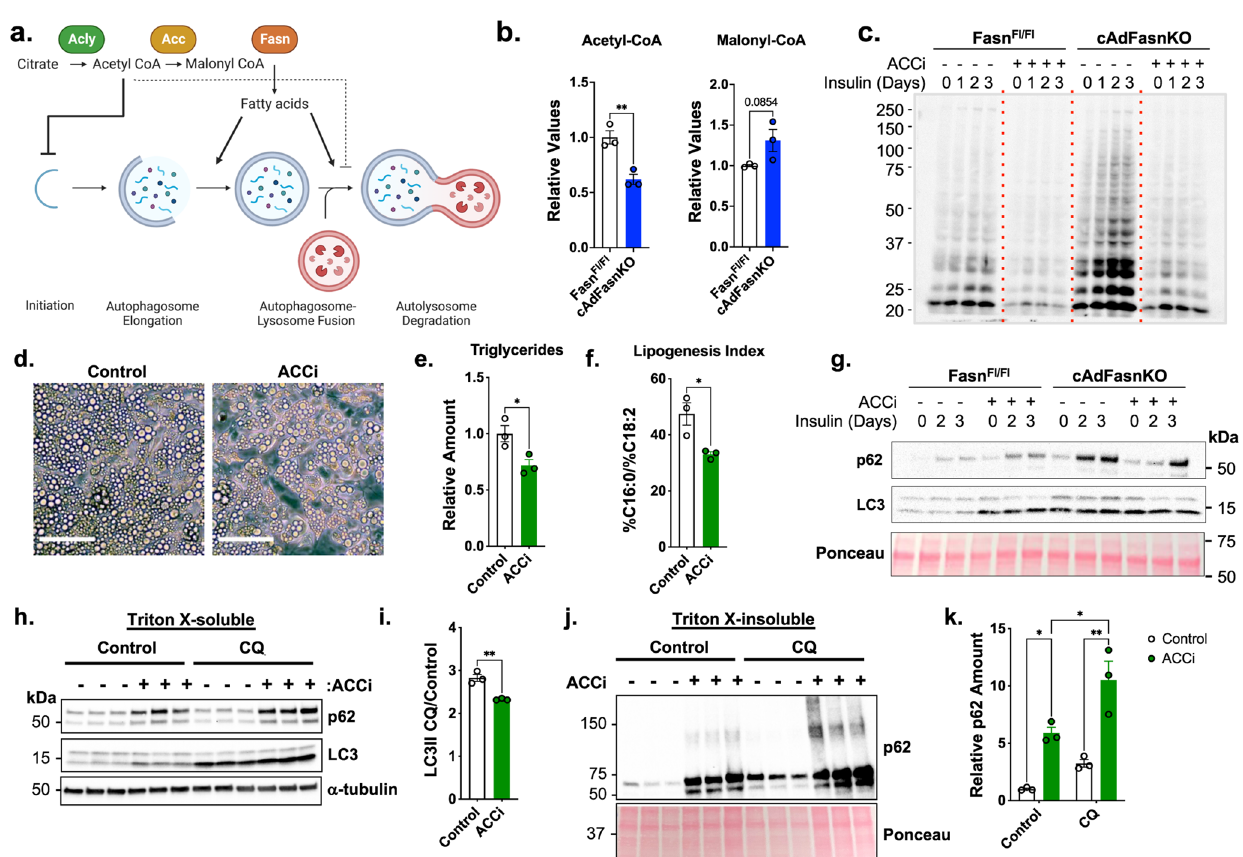
Fig. 2 | DNL metabolites acetyl-CoA and malonyl-CoA do not mediate the impaired autophagy in cultured FasnKO adipocytes. a Diagram of de novo lipogenesis and its proposed role(s) in autophagy. Figure created with BioRender. b Relative acetyl-CoA and malonyl-CoA levels in Fasn Fl/Fl and cAdFasnKO adipo- cytes determined by LC-MS/MS. n =3 samples. Two-tailed t test: P value (Acetyl- CoA) = 0.0075, **<0.01. c Western blot of malonylated proteins in Fasn Fl/Fl and cAdFasnKO adipocytes in the presence of 15 μ M ND-630 (ACC inhibitor, ACCi) for 72h and 1 μ M insulin for the indicated time points. d Light microscopy of in vitro differentiated adipocytes treated with and without 10 μ M ACCi for 48h. Scale bar=50 μ m. e Relativetriglyceridecontentand( f )Lipogenesisindexcalculated as the ratio of the percentage of C16:0 to the percentage of C18:2 in triglycerides in controlandACCi-treatedadipocytes. n =3samples.Two-tailed t test: P values= ( E ) 0.0336, ( f ) 0.0245, *<0.05. g Western blot of soluble p62 and LC3 in Fasn Fl/Fl and